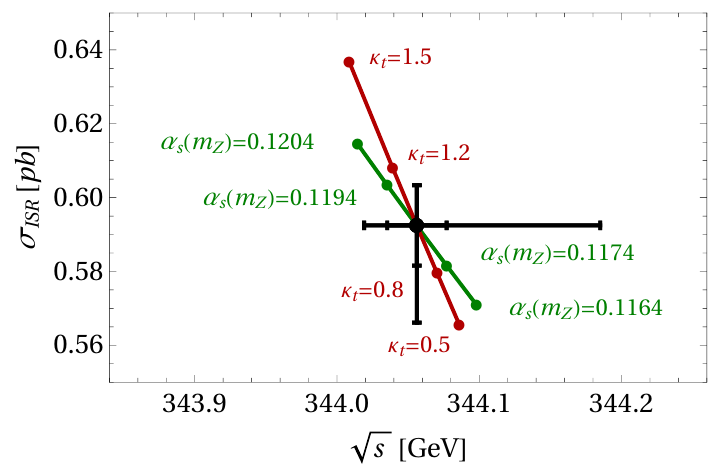
Figure 18 . The e(cid:11)ect of a variation of the Yukawa coupling (strong coupling) on the position and height of the peak is indicated by the red (green) line and points. The black cross represents the theoretical uncertainty with the default input parameters. The outer error bar is obtained by adding the uncertainties from the renormalization scale and variation of (cid:11) s ( m Z ) by quadrature, while the inner bar shows only the latter